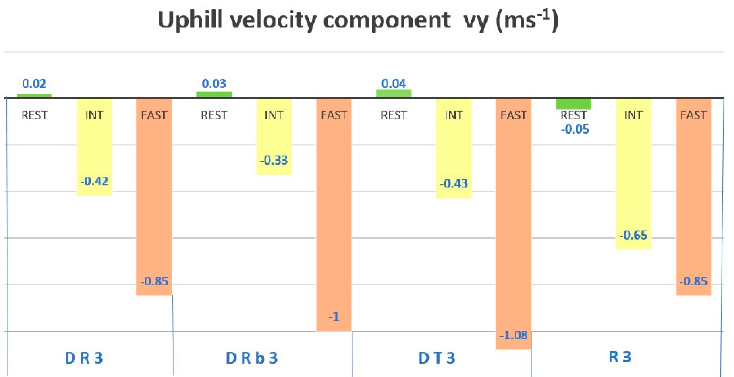
Figure 10. Median values of uphill velocity component by corridor type: fast (FAST), resting (REST) and intermediate (INT) and design layout: rectangular boulder (R3), double rectangular boulder (DR3), double rectangular boulder with a small barrier (DRb3) and double trapezoidal boulder (DT3). Positive values indicate uphill flow and negative values show downhill flow.